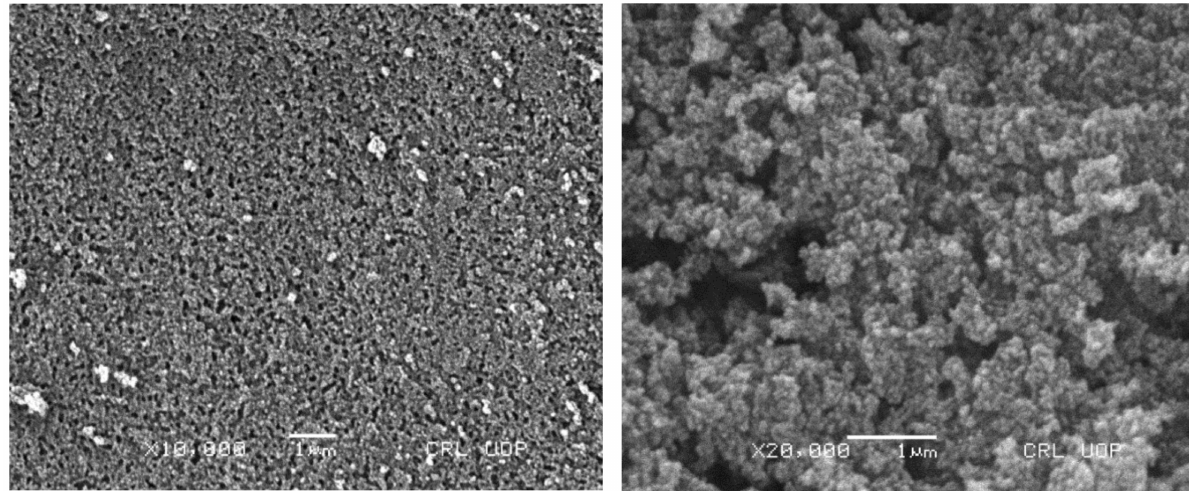
Figure 3. SEM images of nanomatrices formulation at different